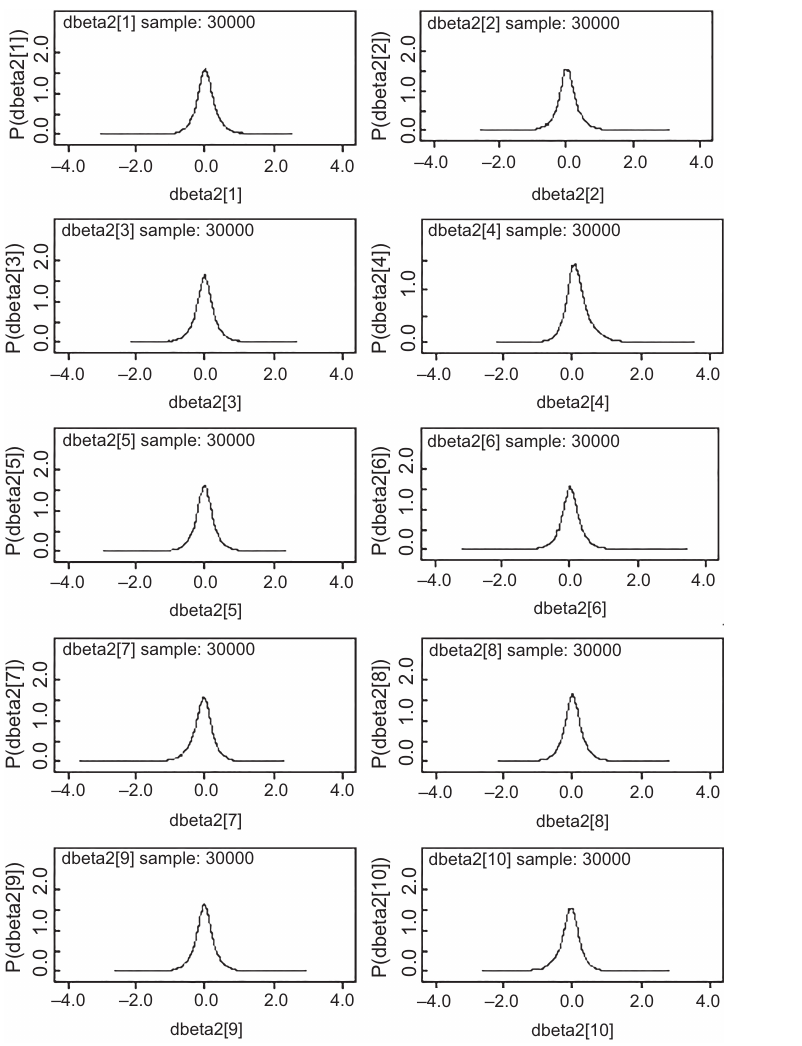
Figure 6. Density plots (selected time periods, k 5 1, 2, ... , 10): Difference between Coefficients on economic development and their (modified) global